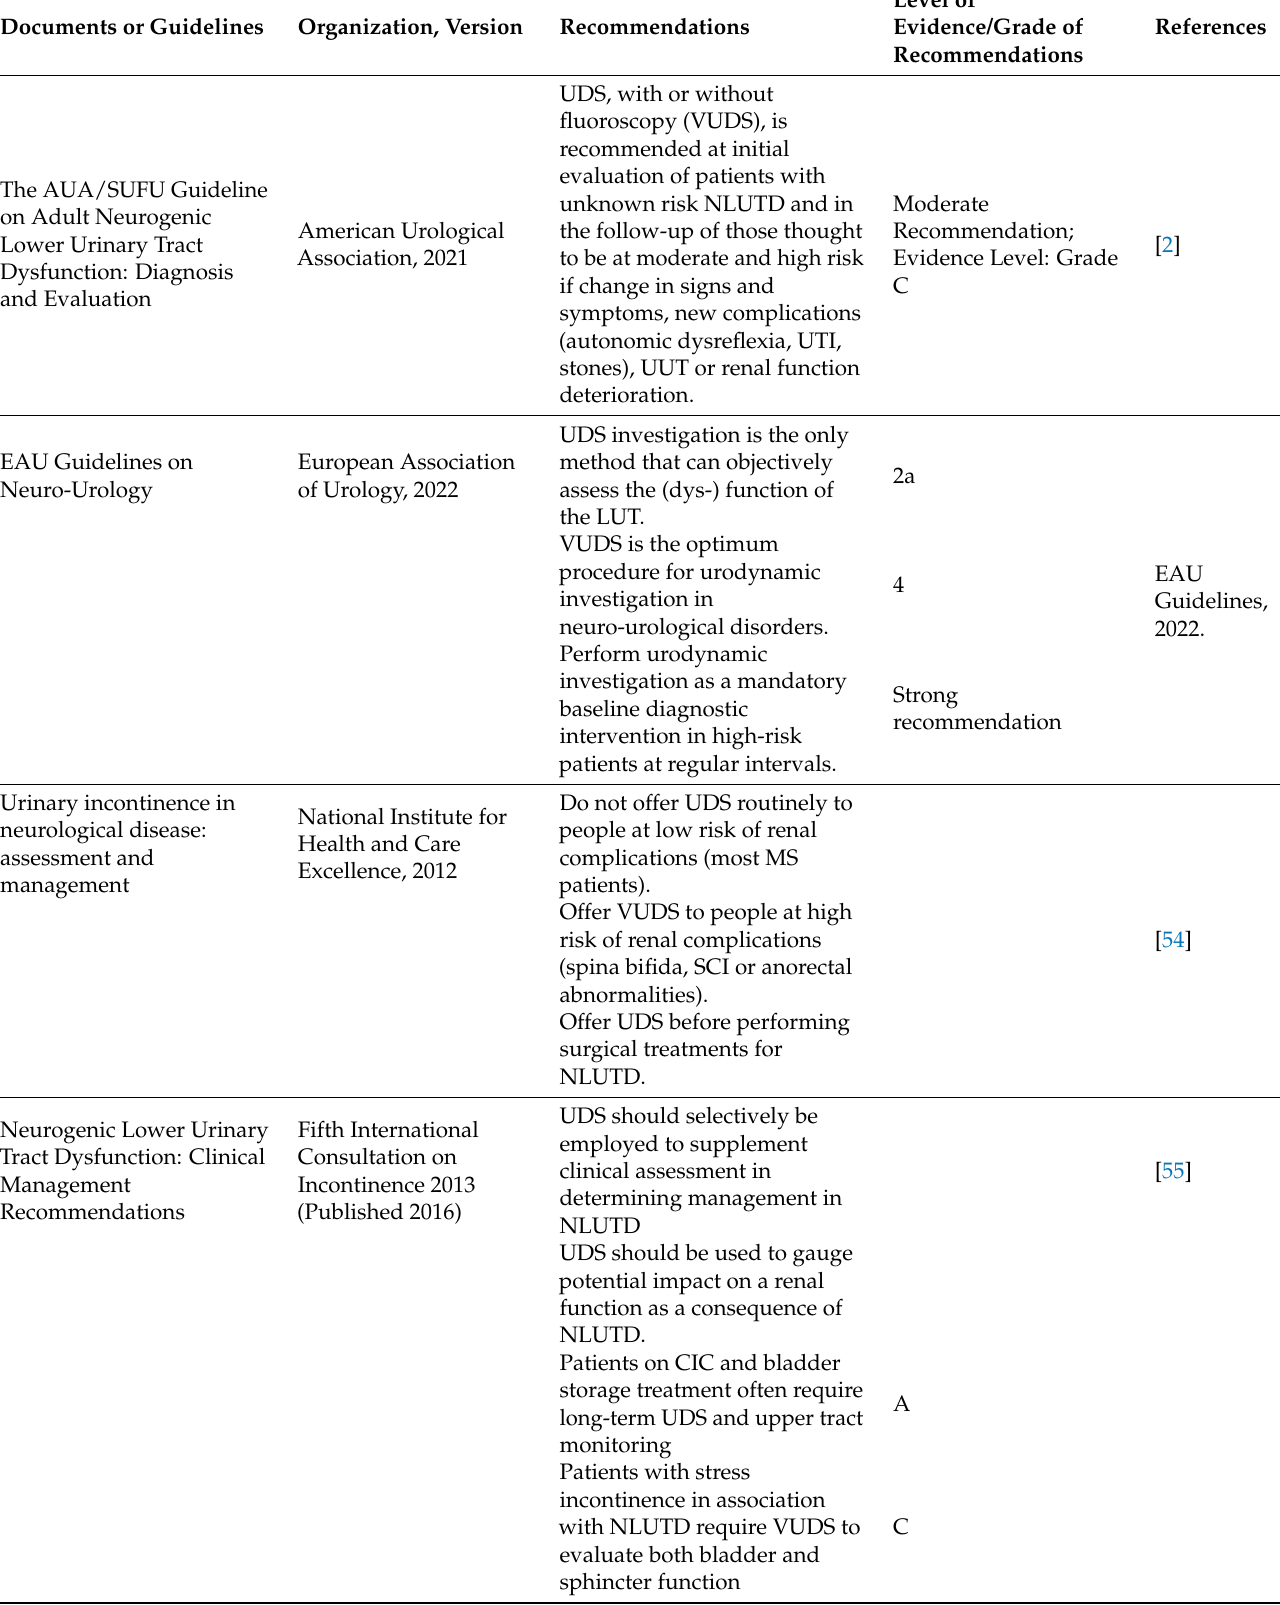
Table 1. Recommendations of several associations on UDS in NLUTD